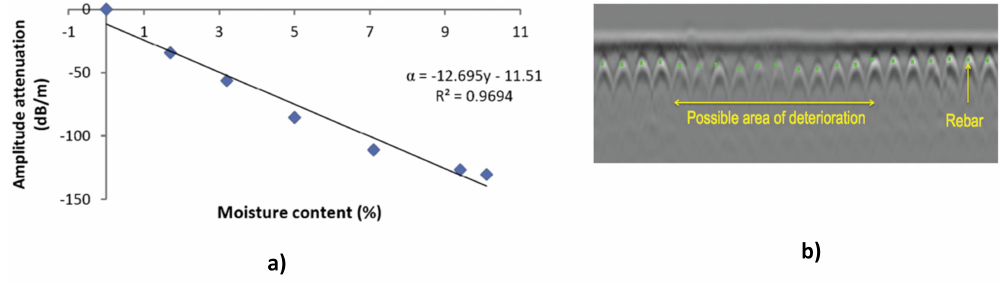
Figure 11. ( a ) GPR signal attenuation with varying moisture content in a concrete sample where α = attenuation (dB m − 1 ), y = moisture content (%) and R 2 = root mean square error [62]; ( b ) GPR image of concrete showing weak reflections from possibly corroded rebar